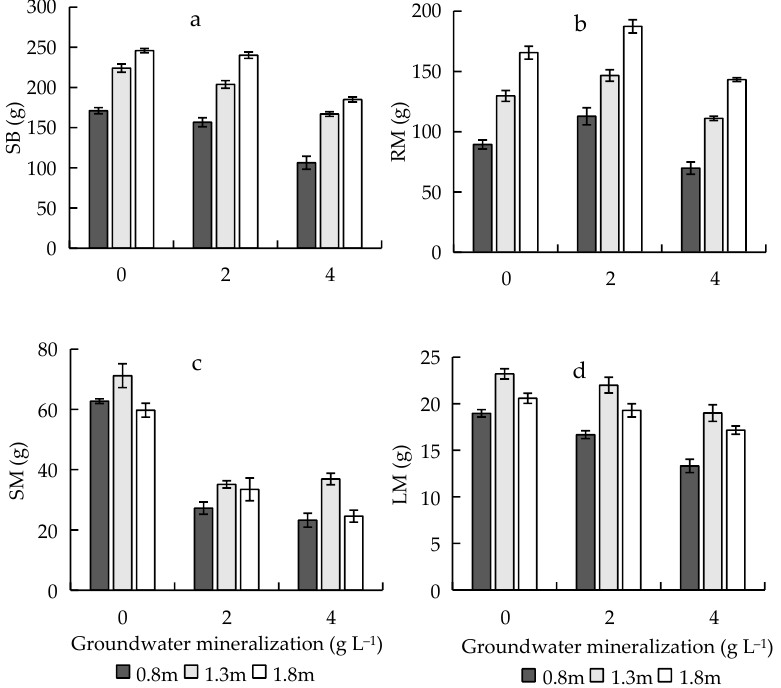
Figure 4. Effects of groundwater mineralization and groundwater depth on biomass characteristics of R. pseudoacacia. ( a ) Sapling biomass; ( b ) root mass; ( c ) stem mass; ( d ) leaf mass. Error bars indicate standard errors (SEs) of the mean.